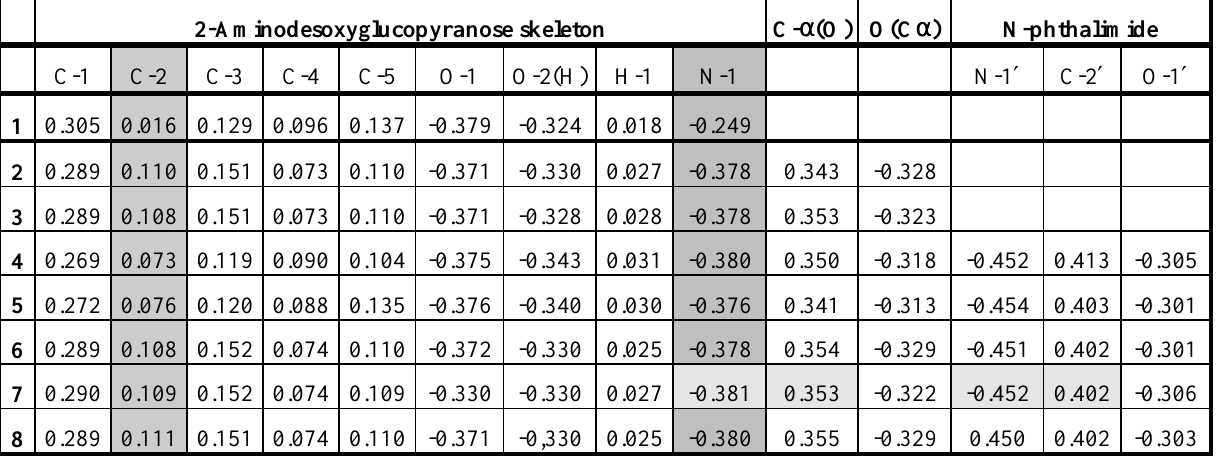
Table 2. Atomic charges of N-acyl-2-aminodesoxyglucopyranoses 1-8.